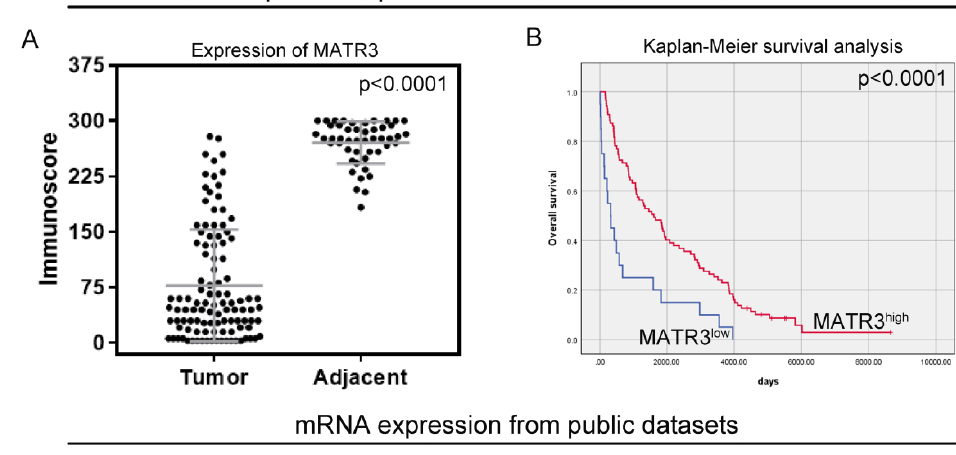
Figure 1. Representative pictures of hematoxylin and eosin staining and immunohistochemical ex- pression of MATR3 in clear cell renal cell carcinoma (ccRCC) and adjacent normal tissues.( A ) hema- toxylin-eosin (HE) staining in adjacent tissue; ( B ) MATR3 staining in adjacent tissue; ( C ) hematox- ylin-eosin (HE) staining in ccRCC; ( D ) negative staining for MATR3 in ccRCC; ( E ) hematoxylin- eosin (HE) staining in ccRCC; ( F ) positive staining for MATR3 in ccRCC (primary magnification ×20). Figure prepared using Adobe Photoshop software.